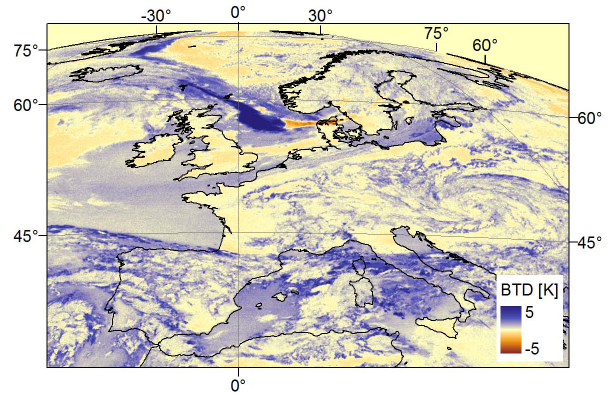
Fig. 6. BTD (data for 15 April at 20:00UTC) reveals plumes dis- persing at two different heights. Highly positive BTD values in dark blue over North Sea indicate ice crystals. Below it spreads a reddish plume with negative